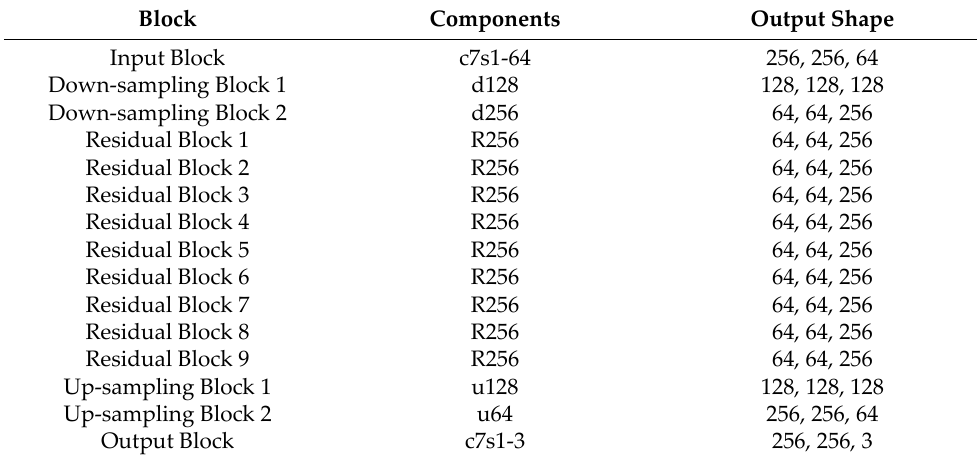
Table A1. Architecture of generator model.